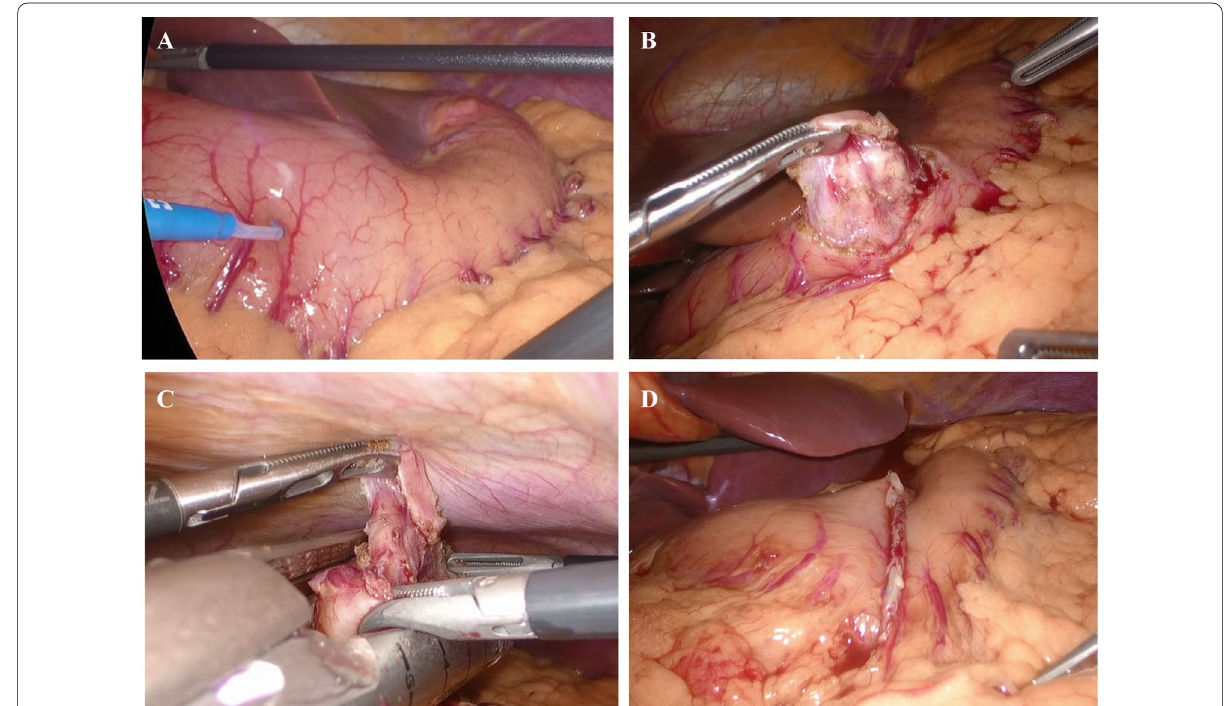
Fig. 2 Intraoperative imaging by laparoscopy. A The tumor could not be identified from the gastric serosa. B The seromuscular layer and submucosal layers were incised completely along the tumor, and the tumor covered with mucosa was towed outside the gastric wall. C The whole layer was excised by linear stapler. D After tumor